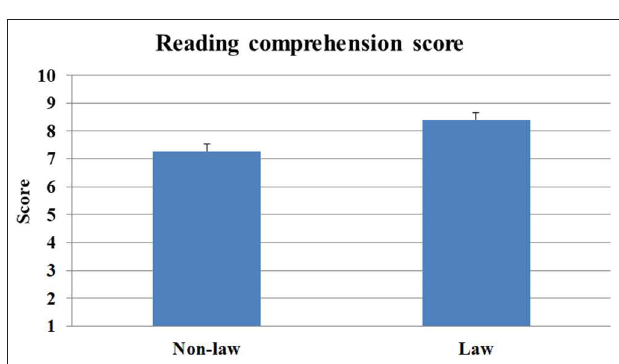
FIGURE 2 | Mean differences in reading comprehension score between non-law and law